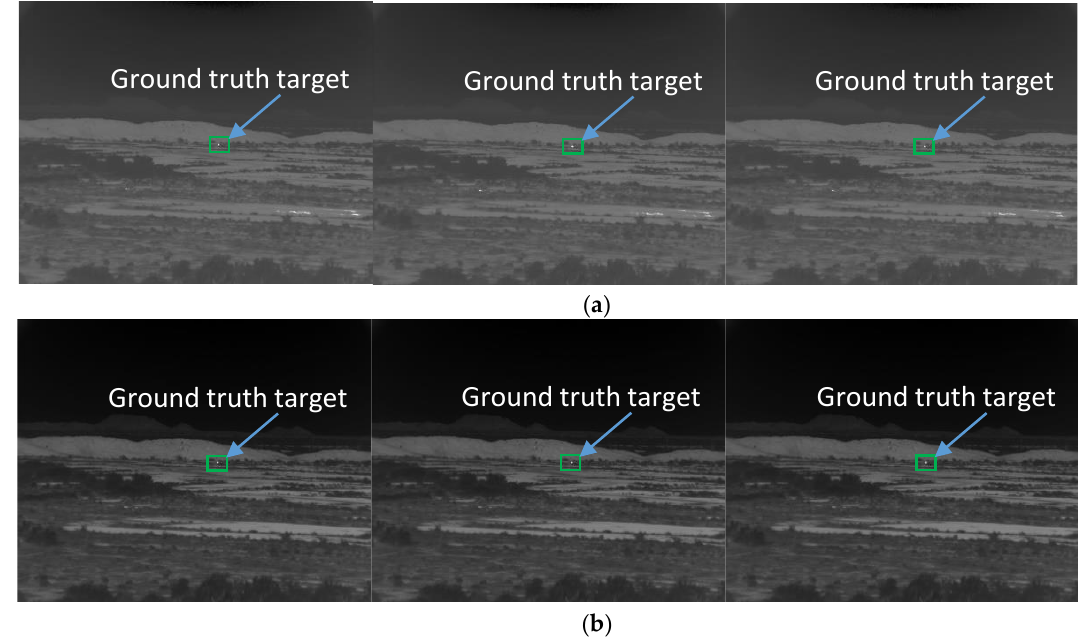
Figure A9. Three frames from 4500 m for Approach 1 and 3a. ( a ) Approach 1; ( b ) Approach 3a.